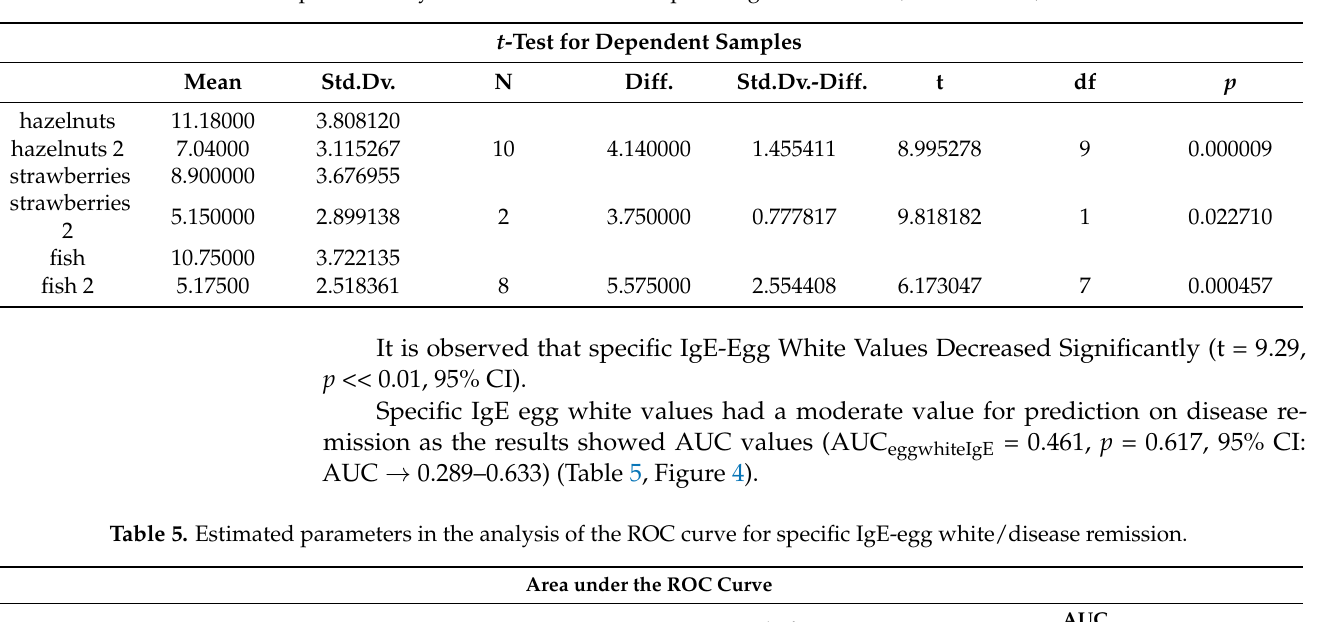
Table 5. Estimated parameters in the analysis of the ROC curve for specific IgE-egg white/disease remission. Variables Tested Factors